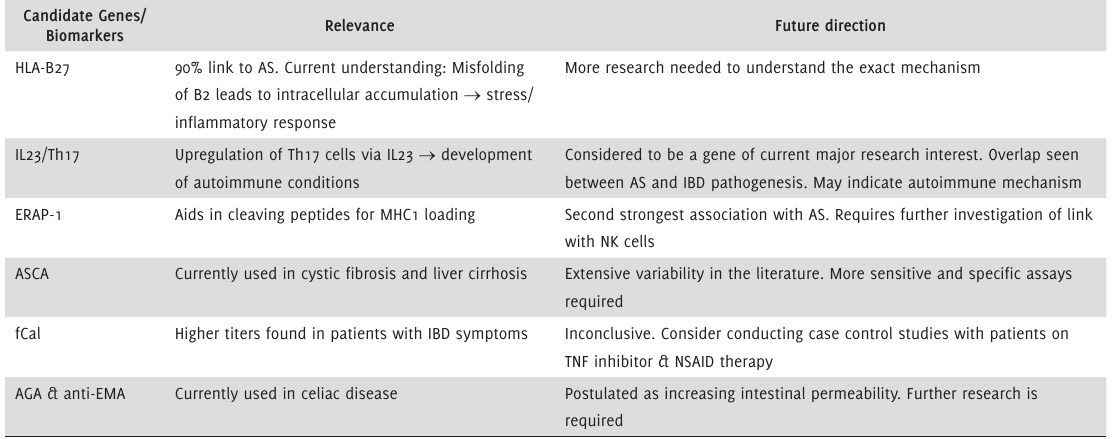
Table 3. Candidate Genes and Biomarkers Outlined in This